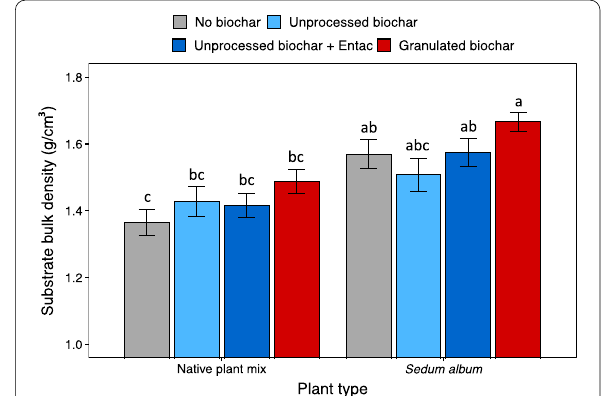
Fig. 4 Substrate bulk density by treatment in green roof modules. Bars plot mean substrate bulk density replicates per treatment). Bars with different lowercase letters differ significantly at P < 0.05 according to Tukey’s HSD test following two-way